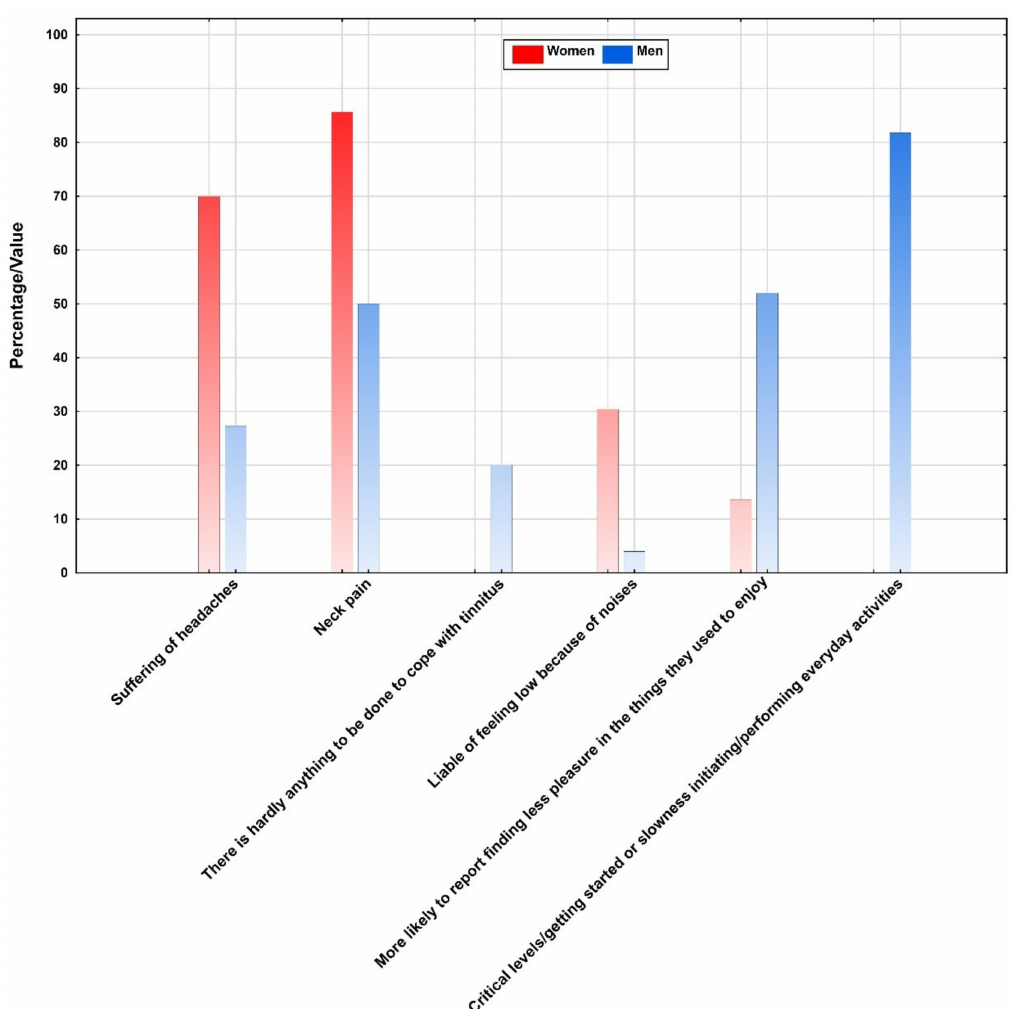
Figure 2. Overall percentage distribution of the statistically significant psychometric outcome variables collected in the